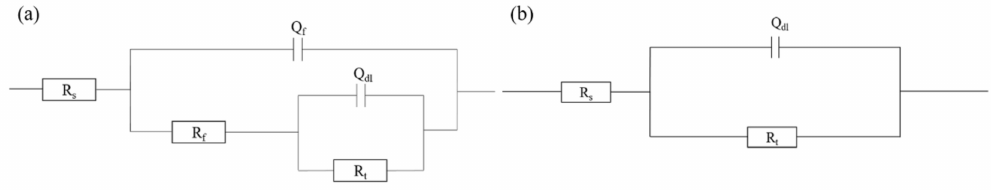
Figure 15. The R s evolution of di ff erent specimens with immersion time.